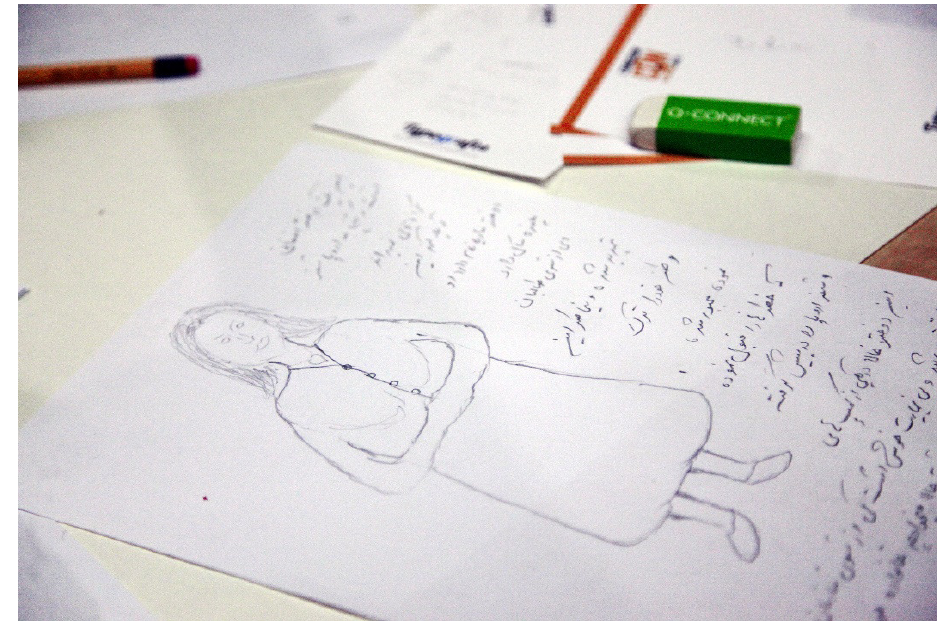
Figure 1. Character design during the Athens Comics Library’s workshops. Inspired by all the aforementioned, Athens Comics